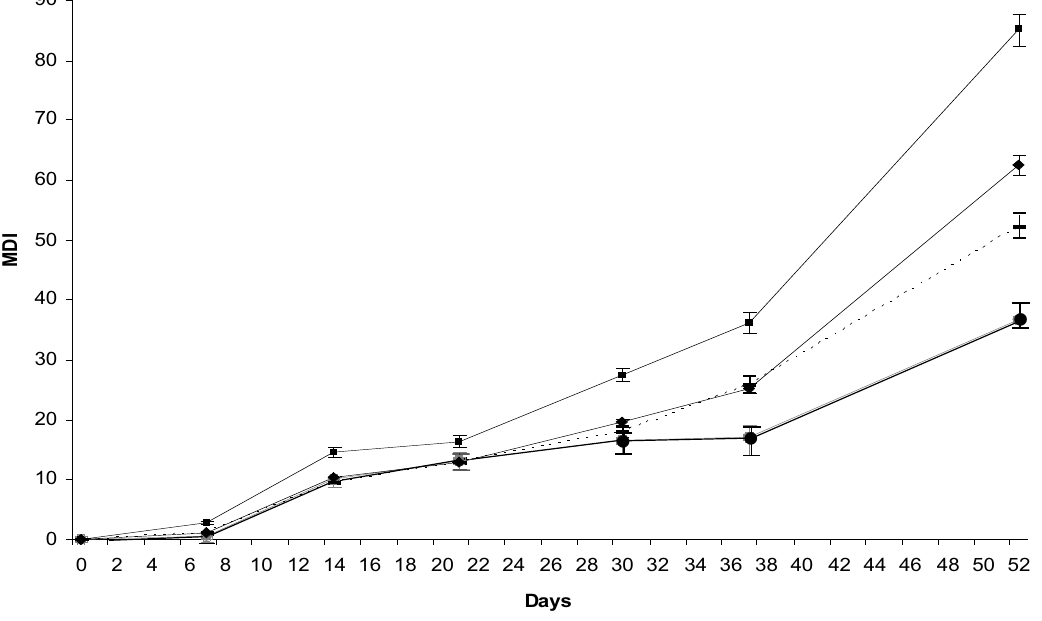
Fig. 3. Mass disease index (MDI) of chocolate spot on leaves under field conditions for: moderately resistant lines with low area under disease progress curves ( ); highly susceptible lines with high AUDPC ( ); moderate- ly susceptible lines with low AUDPC ( ); and susceptible lines with low AUDPC ( ). Bars represent standard deviation.